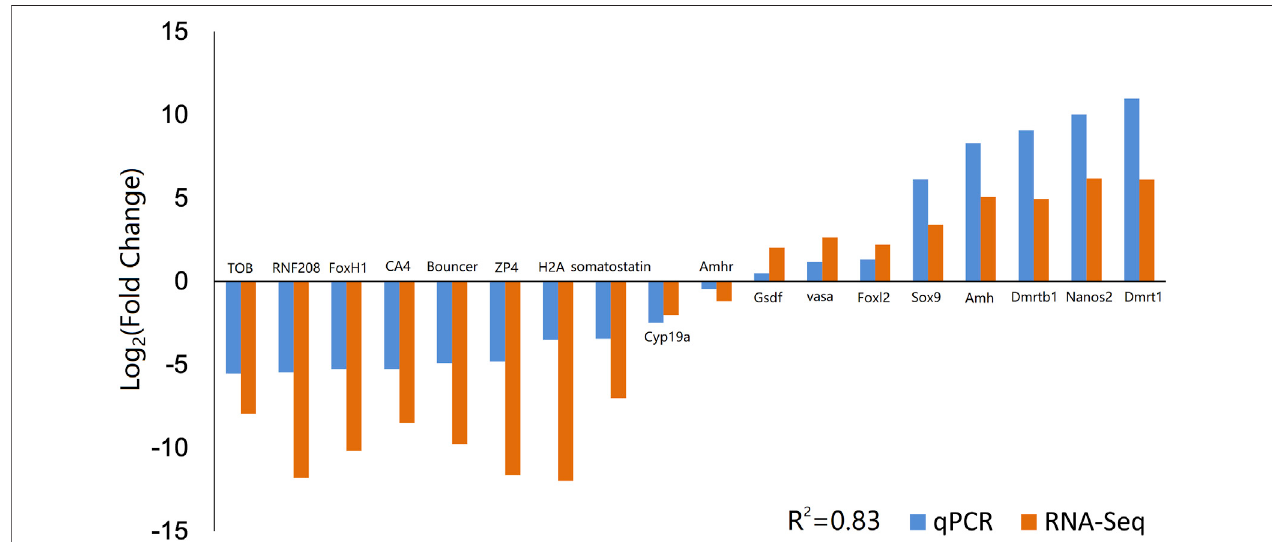
FIGURE 3 | Validation of RNA-Seq data by qPCR. Comparison of the relative log 2 (Fold Change) values of 18 genes between RNA-Seq and qPCR results. qPCR, quantitative PCR.